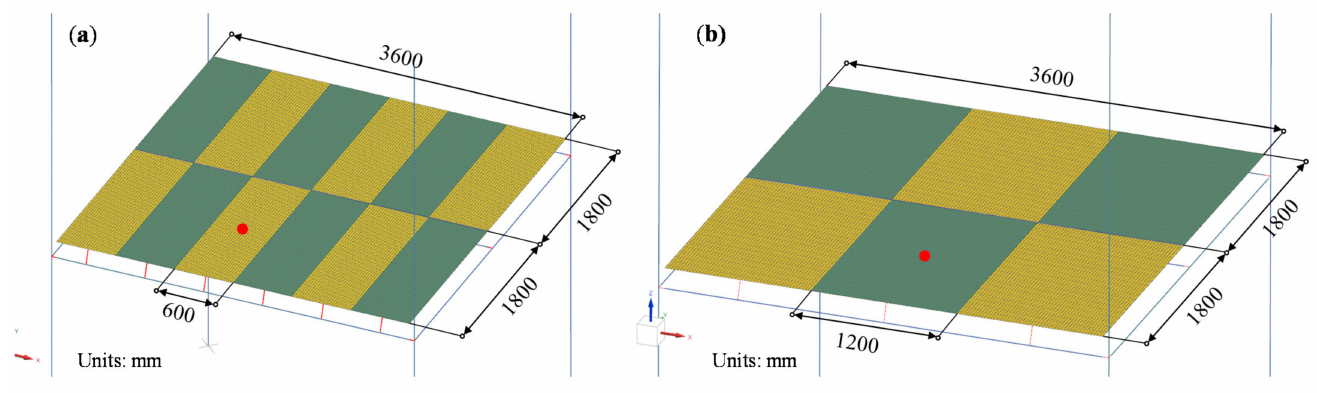
Figure 6. ( a ) Basic numerical model; ( b ) modified numerical model with different ALC floor panel sizes but same frame structure as in model ( a ).